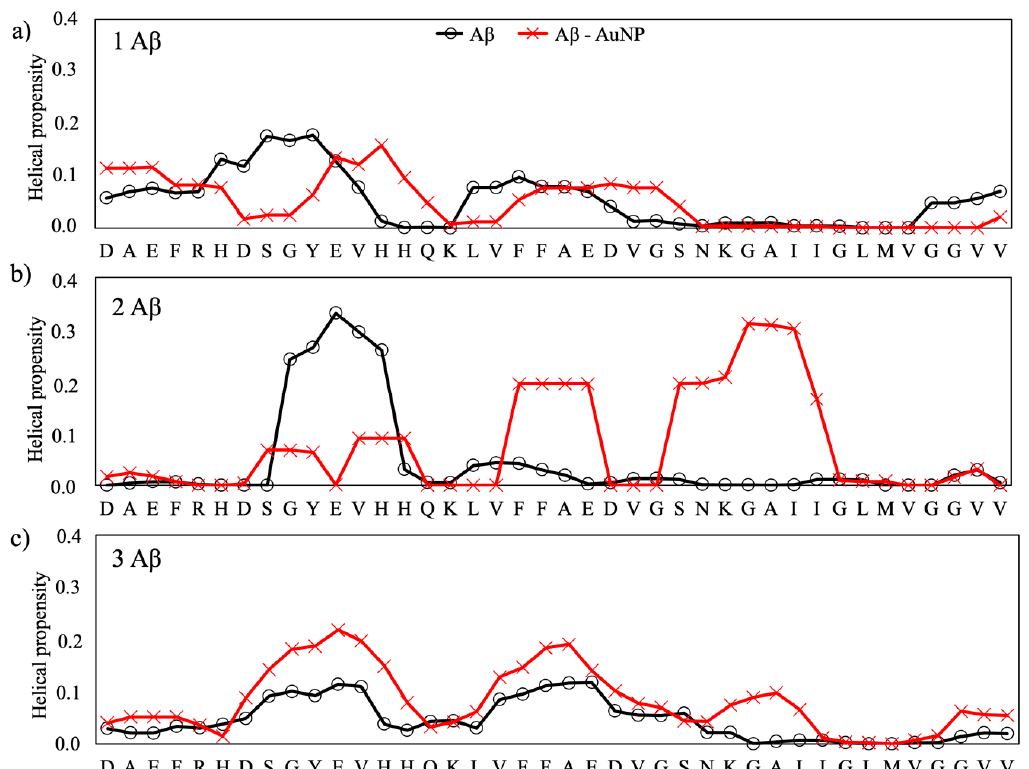
Figure 5. Helical propensity for each residue of the A β (1–40) peptides for the three ratios: 1:1 ( a ), 2:1 ( b ) and 3:1 ( c ).